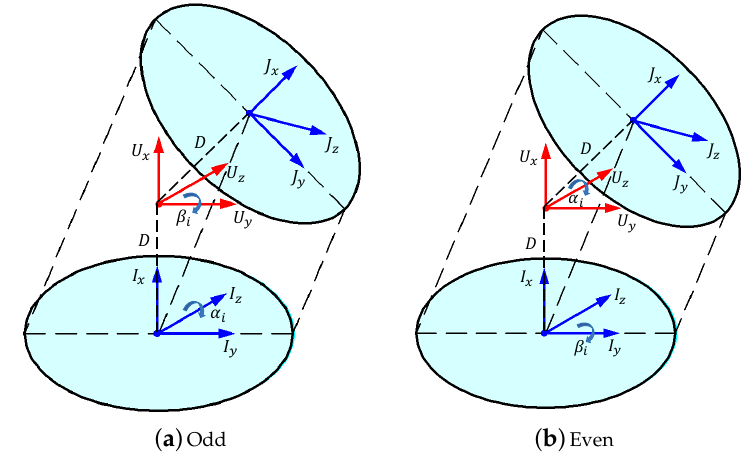
Figure 3. Geometric model of the universal